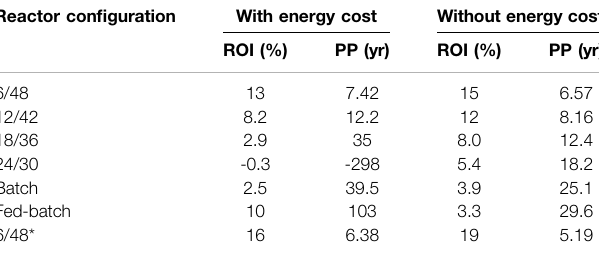
TABLE 3 | Financial analysis of pilot-scale con fi